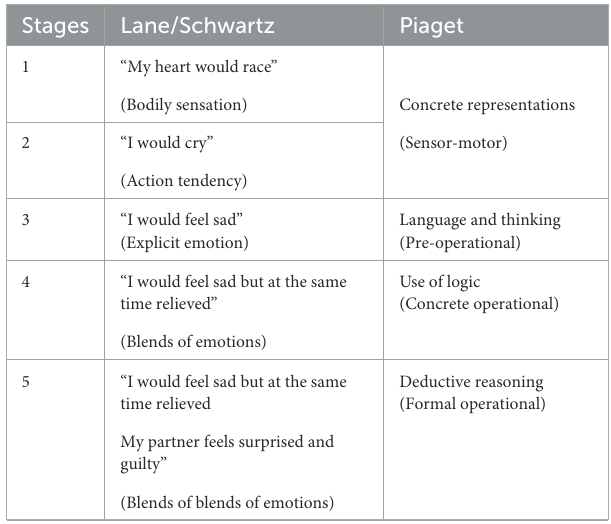
TABLE 1 Comparing the Lane/Schwartz and Piaget models.